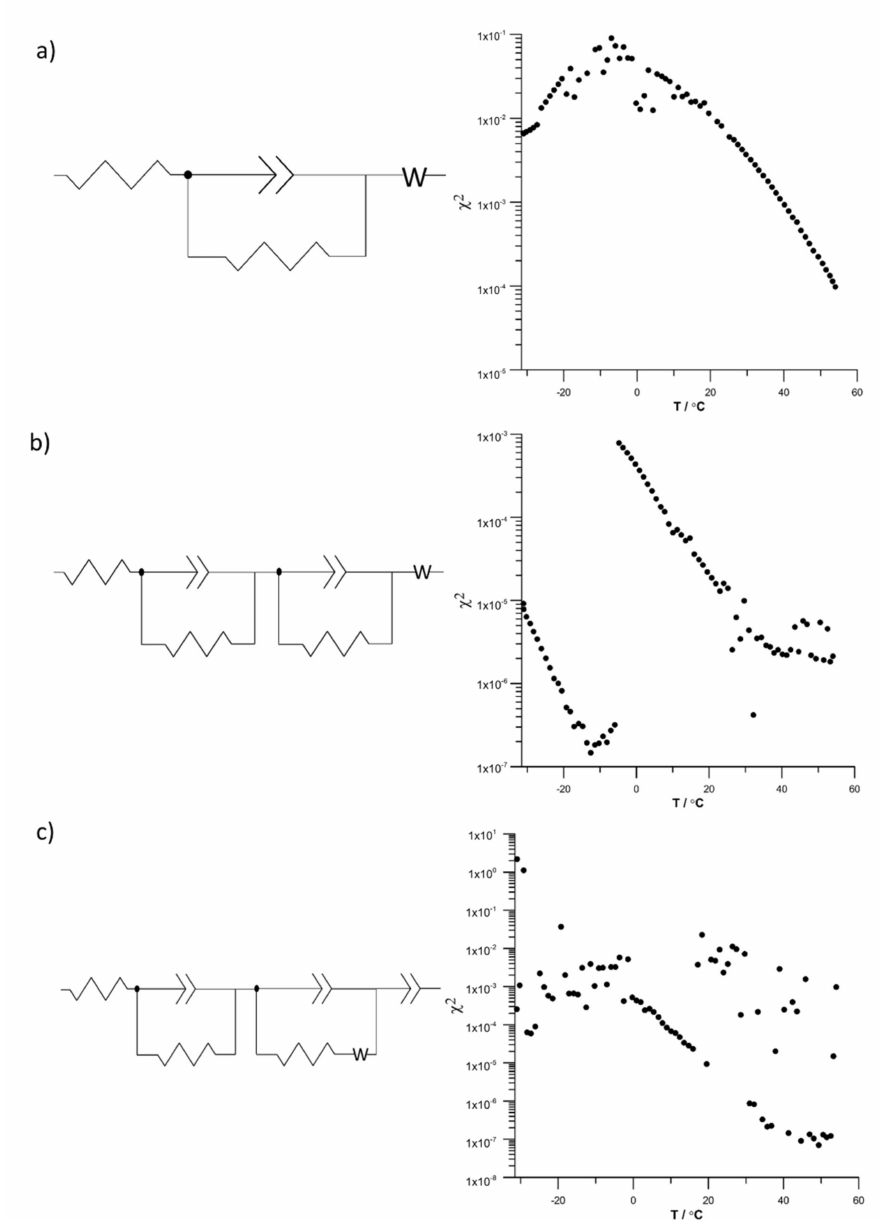
Figure 7. Comparison of chi-square parameter values as a function of temperature for three different equivalent circuits presented in diagrams containing ( a ) one CPE element, ( b ) two CPE elements, and ( c ) three CPE elements. Presented circuits consists of one or a few resistors, constant phase elements, and semi-infinite Warburg impedance